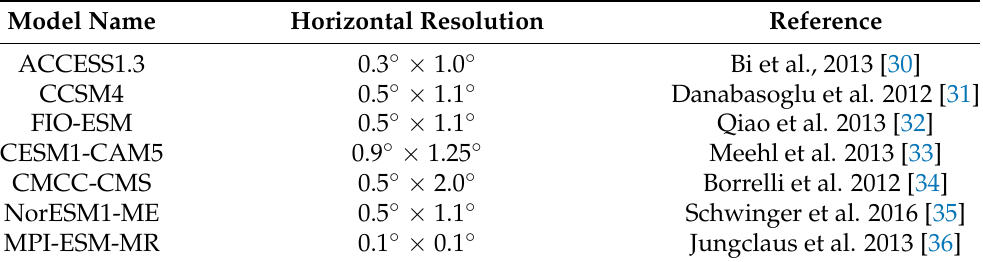
Table 1. CMIP5 models used in this paper: model name, average horizontal resolution (latitude × longitude), and reference. MPI-ESM-MR, Max Planck Institute Earth System Model of medium